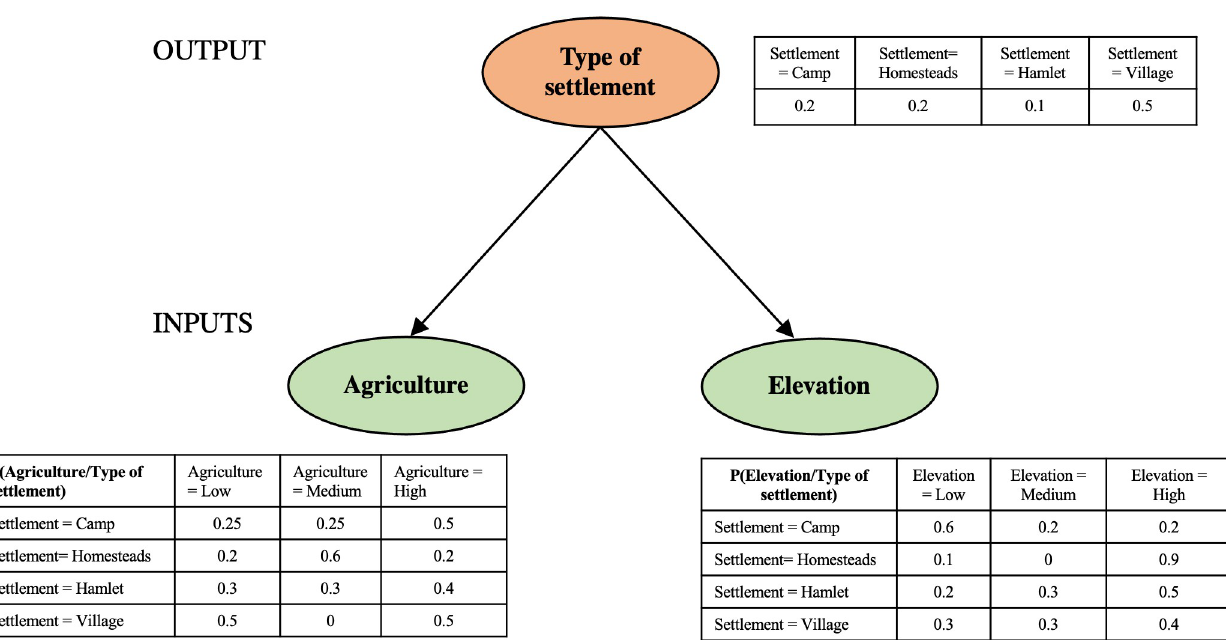
PLOS ONE | https://doi.org/10.1371/journal.pone.0276088 October 26,